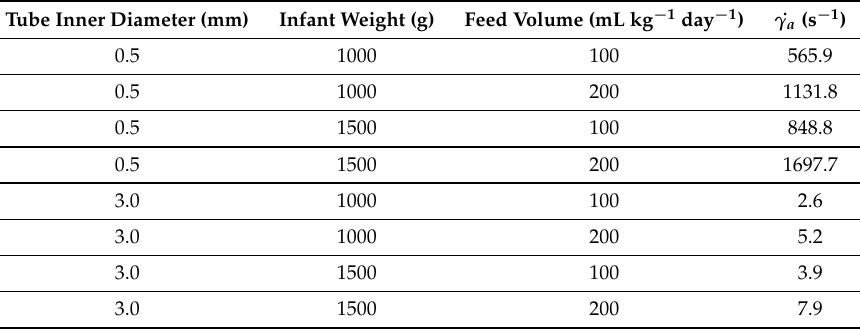
Table A1. Approximations of ˙ γ a in Bolus Feeds over 20 min every 2